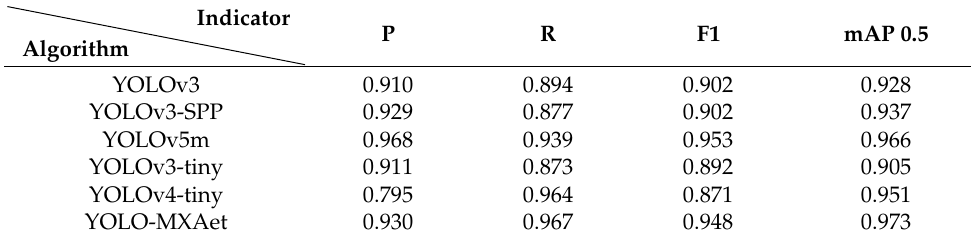
Figure 6. The detection results of YOLOv3 and YOLO-MXANet on the KITTI dataset. ( a ) YOLOv3. ( b ) YOLO-MXANet. Table 3. The comparison results of the algorithms on the CCTSDB